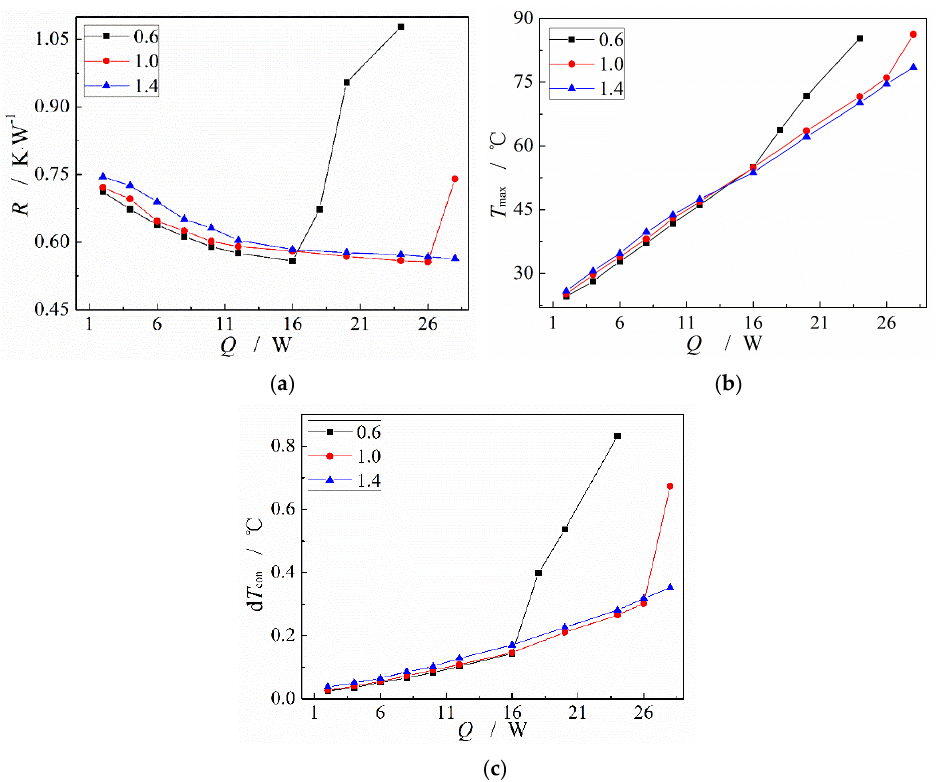
Figure 12. Heat transfer performance of copper oxide MGFHP filled with deionized water under different filling ratios: ( a ) thermal resistance; ( b ) maximum temperature at evaporation section; and ( c ) temperature uniformity at condensation section.